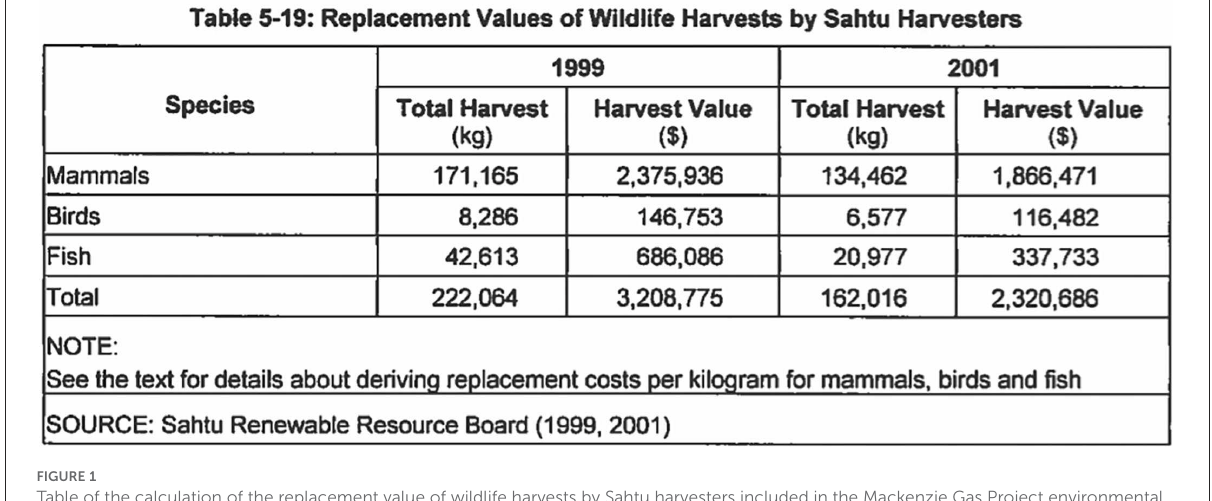
though you gave us lots of money, but if there’s no animal, what’s the use?”